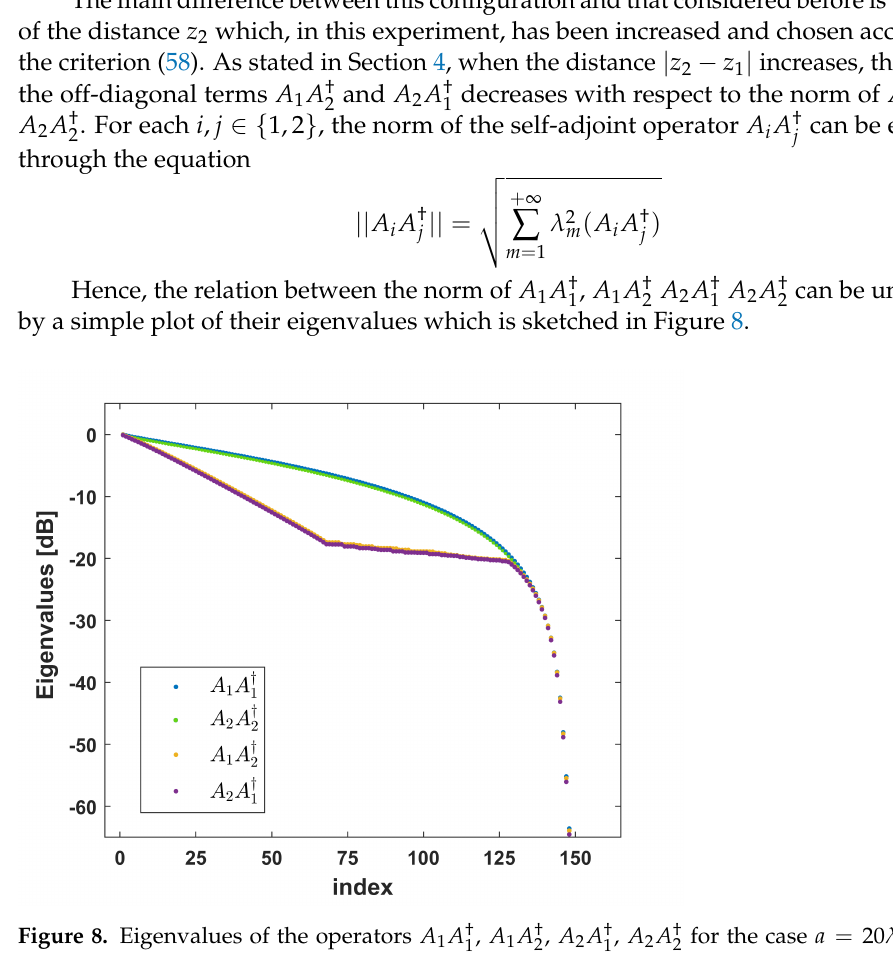
, A 1 A † , A 2 A † , A 2 A † for the case a = 20 λ , z 1 = 5 λ , 2 2 1 1